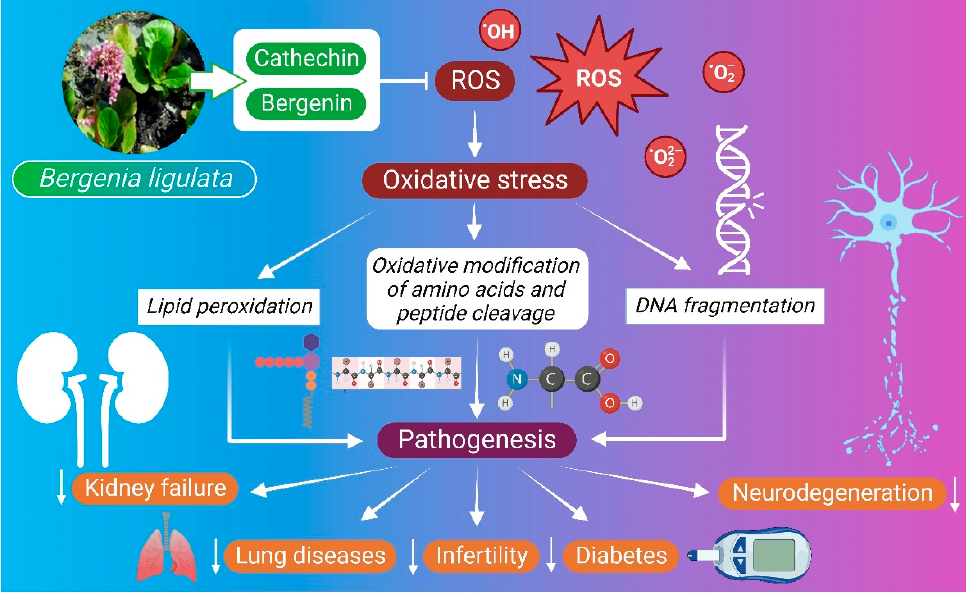
Figure 3. Antioxidative mechanism of B. ligulata . Bergenin has been attributed to the free radical scavenging capacity against hydroxyl radicals through the formation of aromatic conjugated dienes and Fe (II) complex, which ultimately block the generation of hydroxyl radicals. One of the com- pounds of B. ligulata, 11-O-galloylbergenin, has a special structural orientation due to the presence of two meta and one para group, which induces free radical scavenging by the herb. ROS—reactive oxygen species.